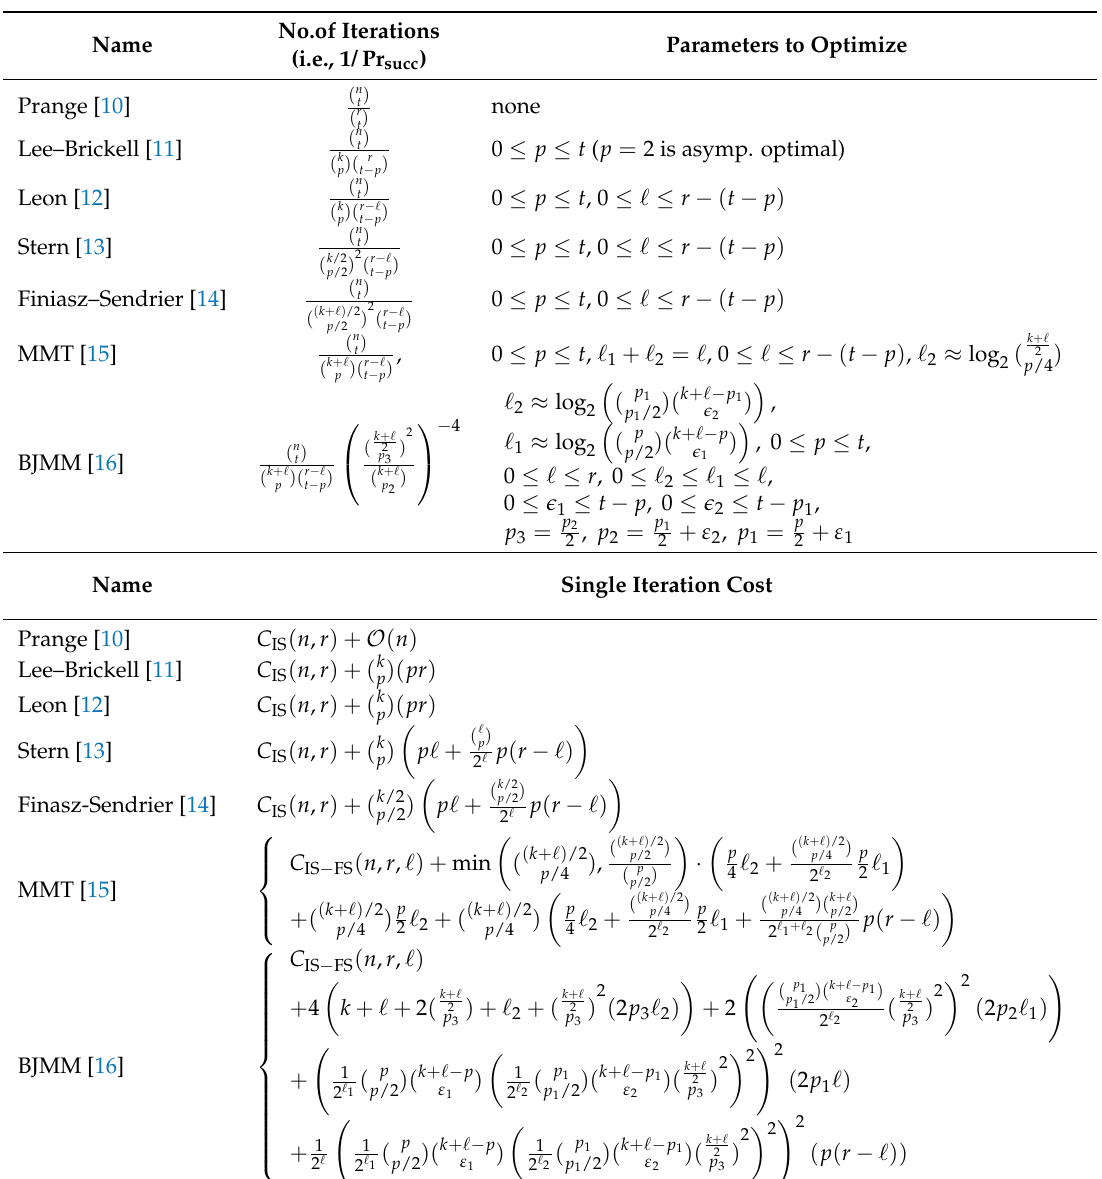
Table 1. Overview of ISDs costs in terms of execution time complexities, considering a constant access memory cost model, expressed as: Cost = NumberOfIterations × Cost single iteration